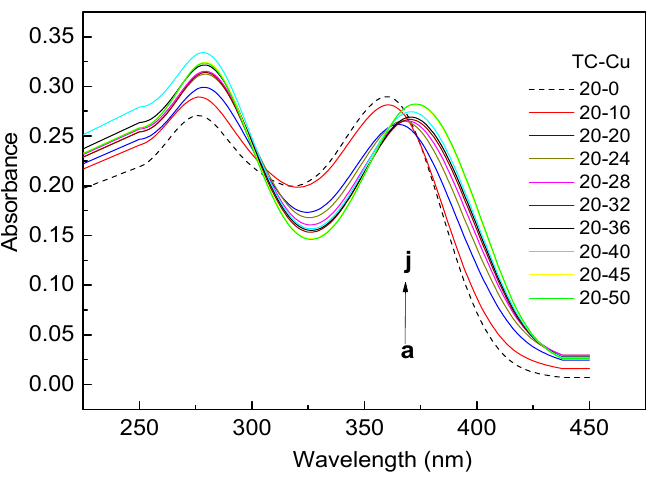
Figure 2. UV-Vis absorbance spectra of TC in the absence (dashed line) and presence (solid line) of Cu(II) ranging from 250 to 450 nm at [TC] =2 0 µM with [Cu] 2+ at: a, 0; b, 10; c, 20; d, 24; e, 28; f, 32; g, 36; h, 40; i, 45; j, 50 respectively (pH = 6).